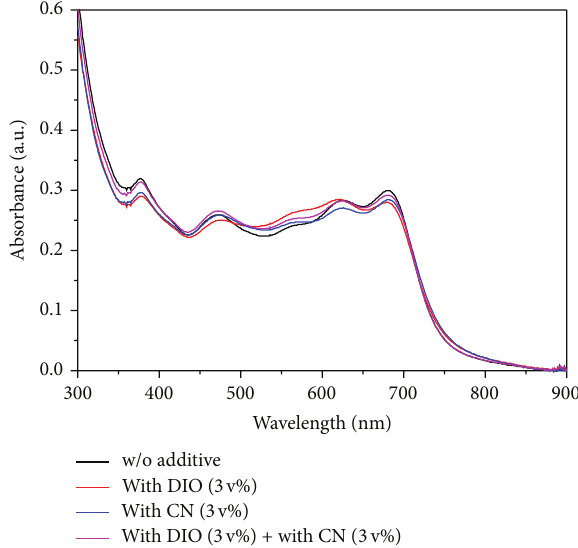
Figure 3: J - V characteristics of the four different organic thin film solar cell devices based on blended active layer of PTB7:PC 71 BM prepared with different organic solvent mixture.